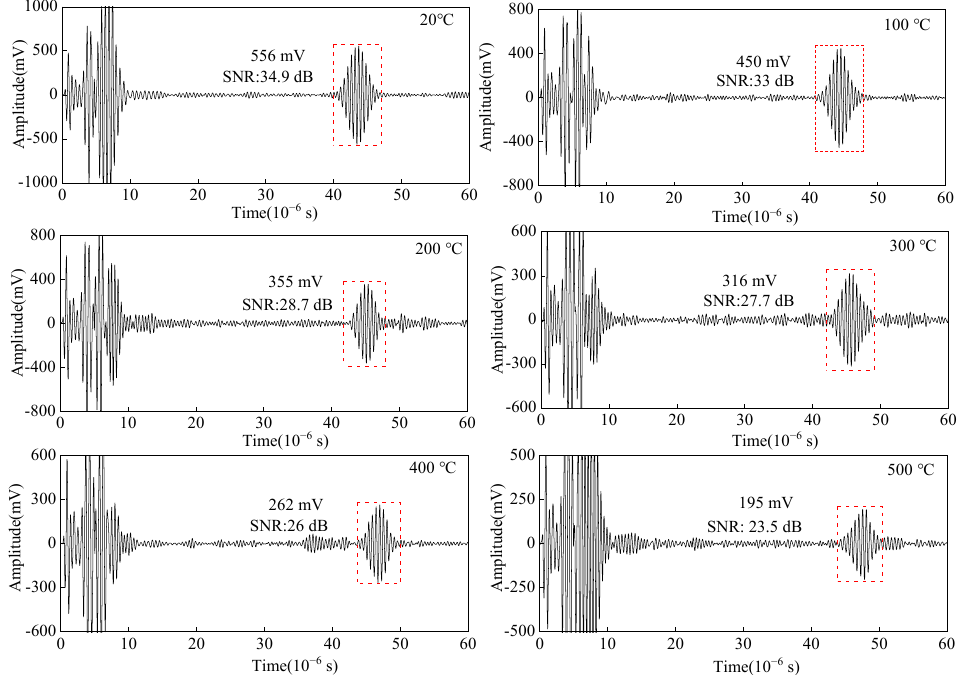
Figure 15. Detected reflected ultrasonic wave signal of angled SV wave EMAT in carbon steel specimens from 20 °C to 500 °C.